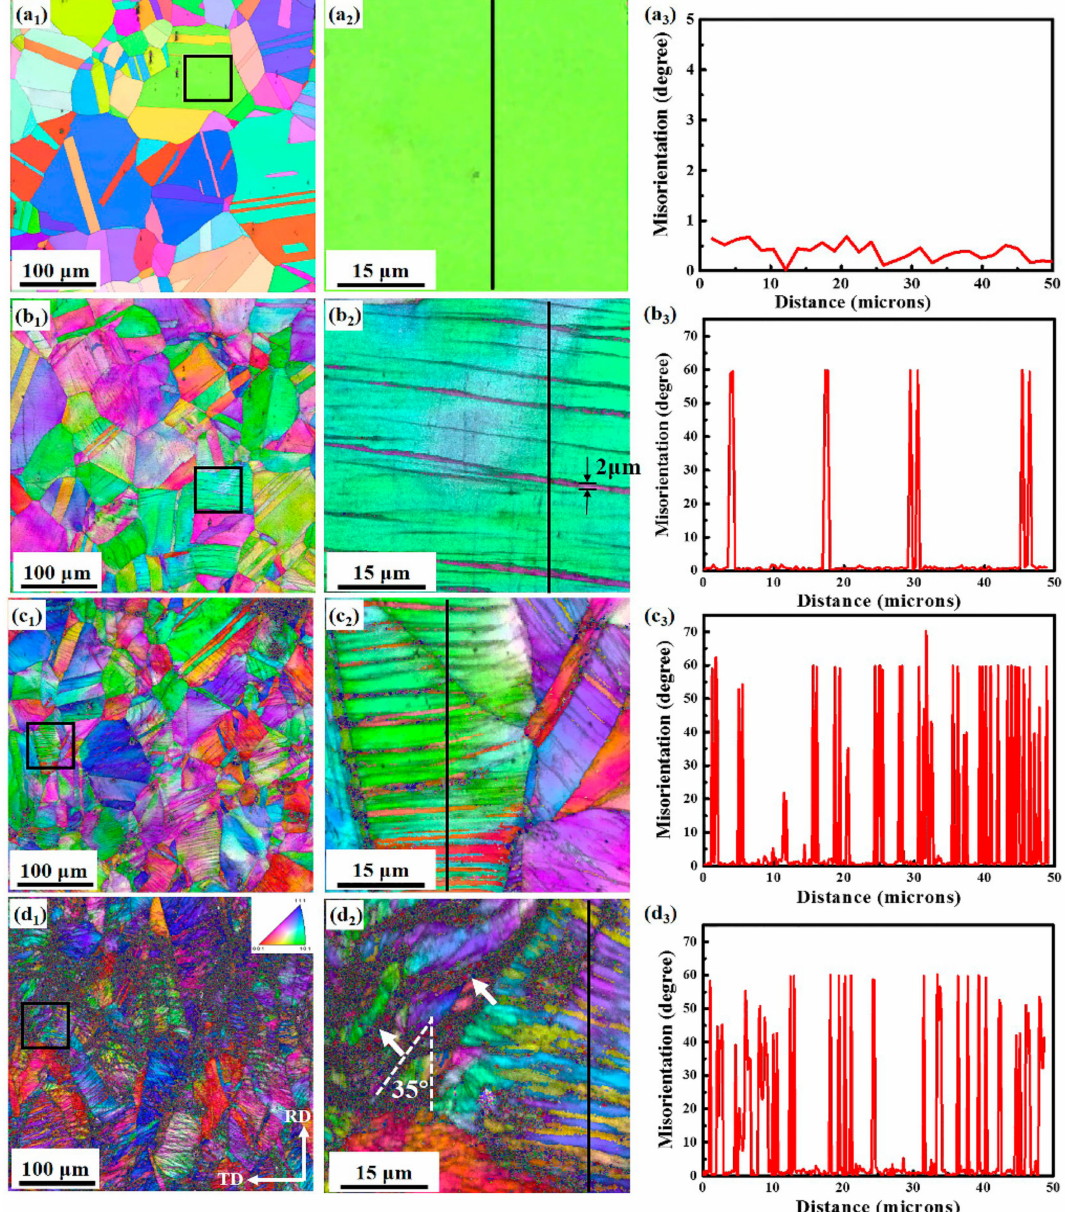
Figure 3. Electron back scattering diffraction (EBSD) maps showing the microstructure of specimens with different warm rolling reductions ( a ) 20%, ( b ) 35%, ( c ) 55%. The inverse pole figure maps of rolling direction (RD) ( a 1 , b 1 , c 1 ) and the corresponding enlarged images ( a 2 , b 2 , c 2 ) taken from the framed area are given. The misorientation profiles ( a 3 , b 3 , c 3 ) measured along the lines indicate the existence of intragranular grain boundaries with a misorientation of 60 ◦ (twin